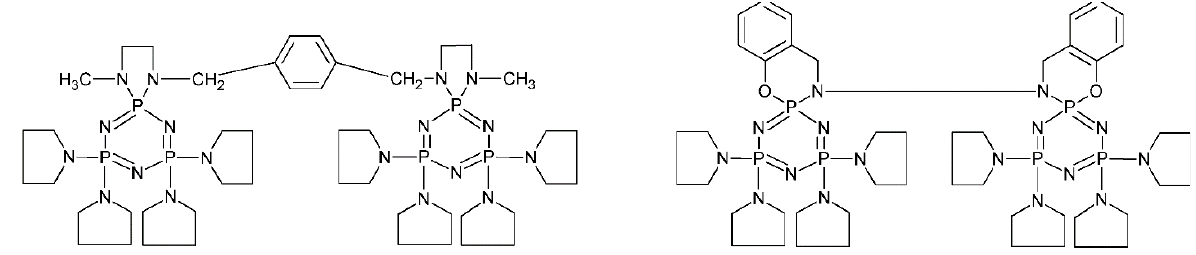
Figure 9. Dimeric cyclophosphazenes with biological activity. The compound on the left also exhibited high cytotoxicity against fibroblast cells; the compound on the right was found to be active against yeast strain C. tropicalis .